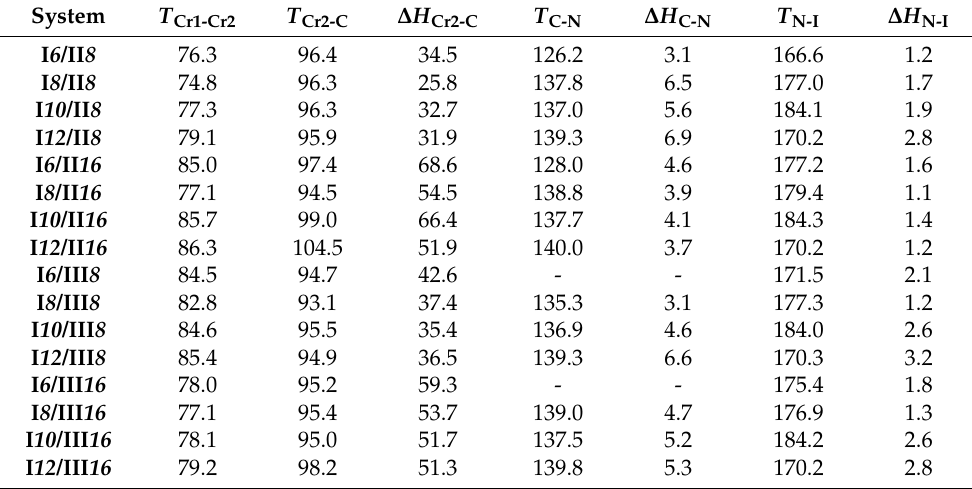
Table 1. Phase transition temperatures ( ◦ C), enthalpy of transitions (kJ/mol) for the supramolecular complexes I n / II m and I n / III m